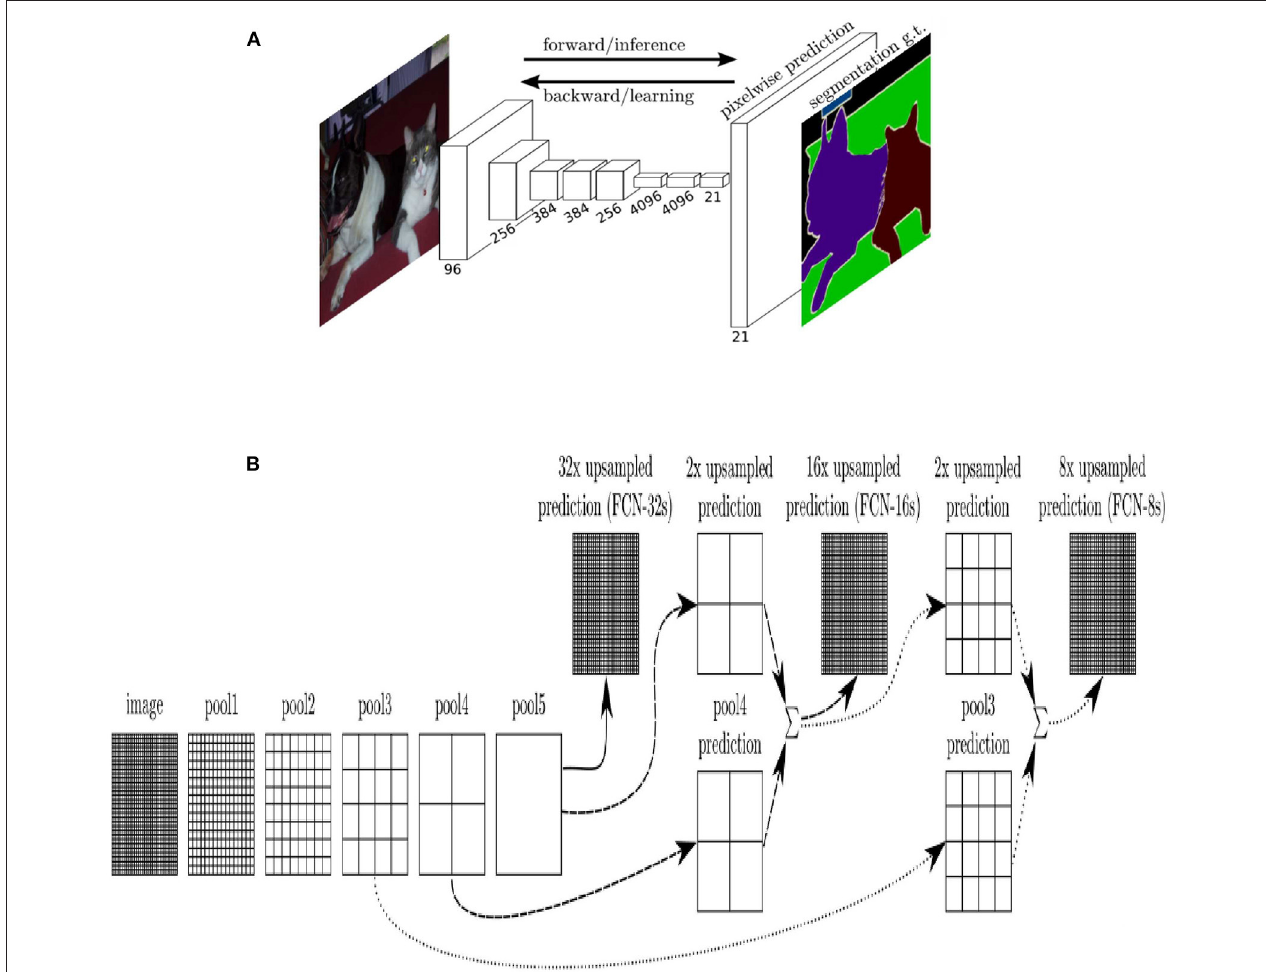
FIGURE 1 | (A) FCN model with VGG as backbone, (B) skip layer of FCN: FCN-32s means output image is recovered by up-sampling directly, which has the lowest precision because of the lack of feature fusion. FCN-16s merge the feature map extracted from the last network with the feature map extracted from the previous layer before the output image is recovered. FCN-8s merge one more feature map than 16s, which has the highest